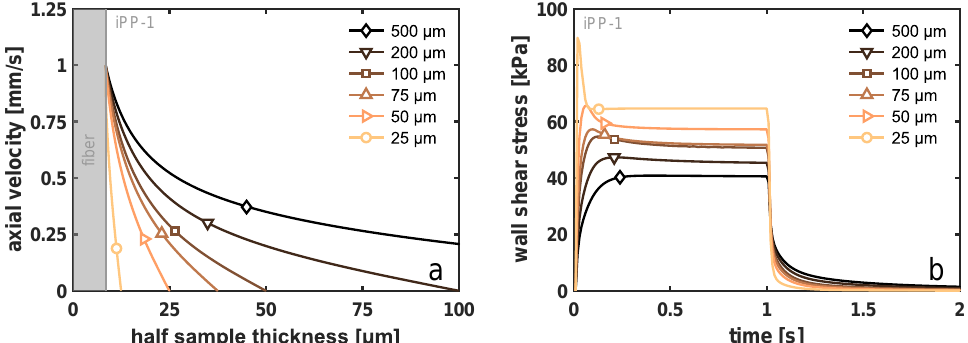
Figure 11. ( a ) The steady-state velocity profiles over the sample thickness during a step-shear-rate experiment, i.e., 1 mm/s for 1 s, for varying sample thicknesses, and ( b ) the corresponding time evolution of the wall shear stress at the fiber